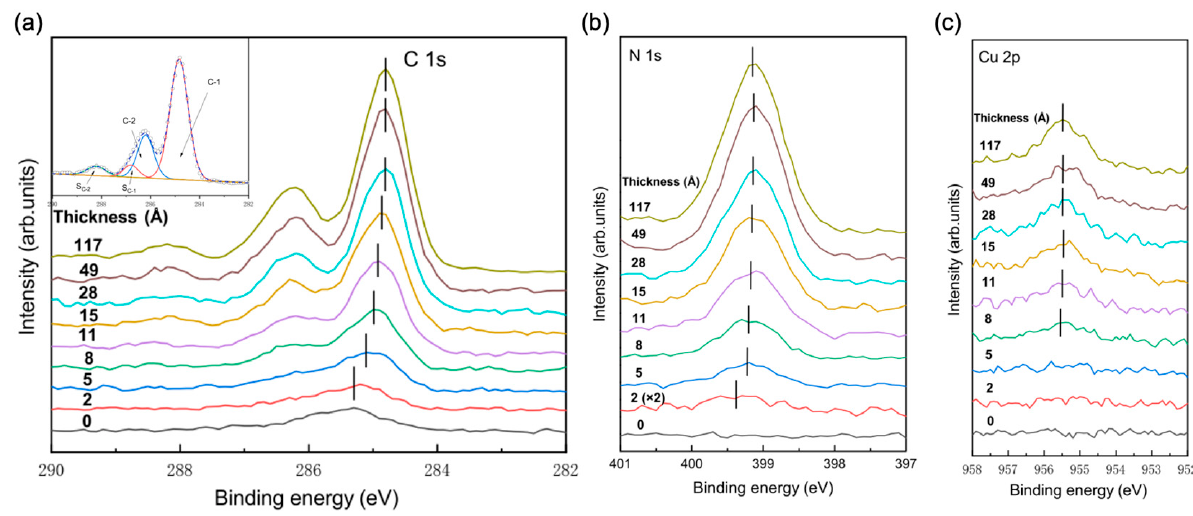
Figure 3. Thickness-dependent ( a ) C 1 s , ( b ) N 1 s and ( c ) Cu 2 p core-level spectra at CuPc/CsPbI 2 Br interface. The inset in panel a show the fitting curves for 117 Å CuPc film.